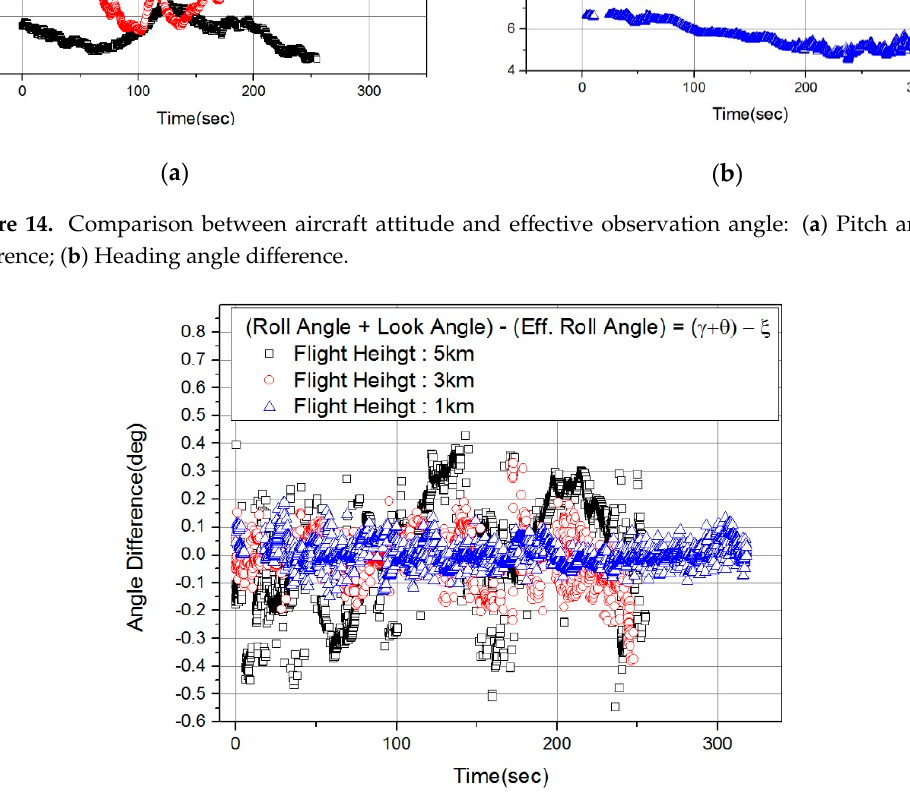
Figure 15. Difference between angles ( γ + θ ) and ξ .